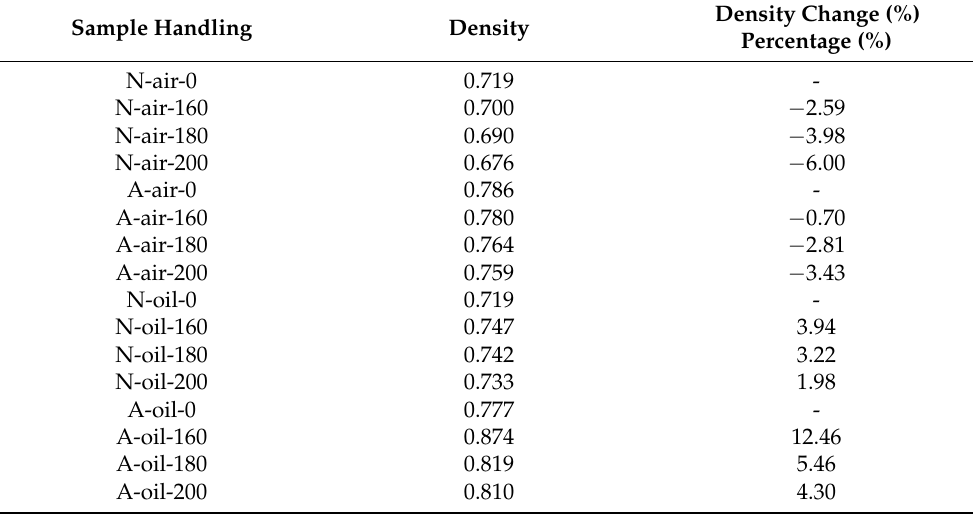
Table 3. The influence of heat treatment under air or palm oil on Afrormosia and Newtonia density. Sample